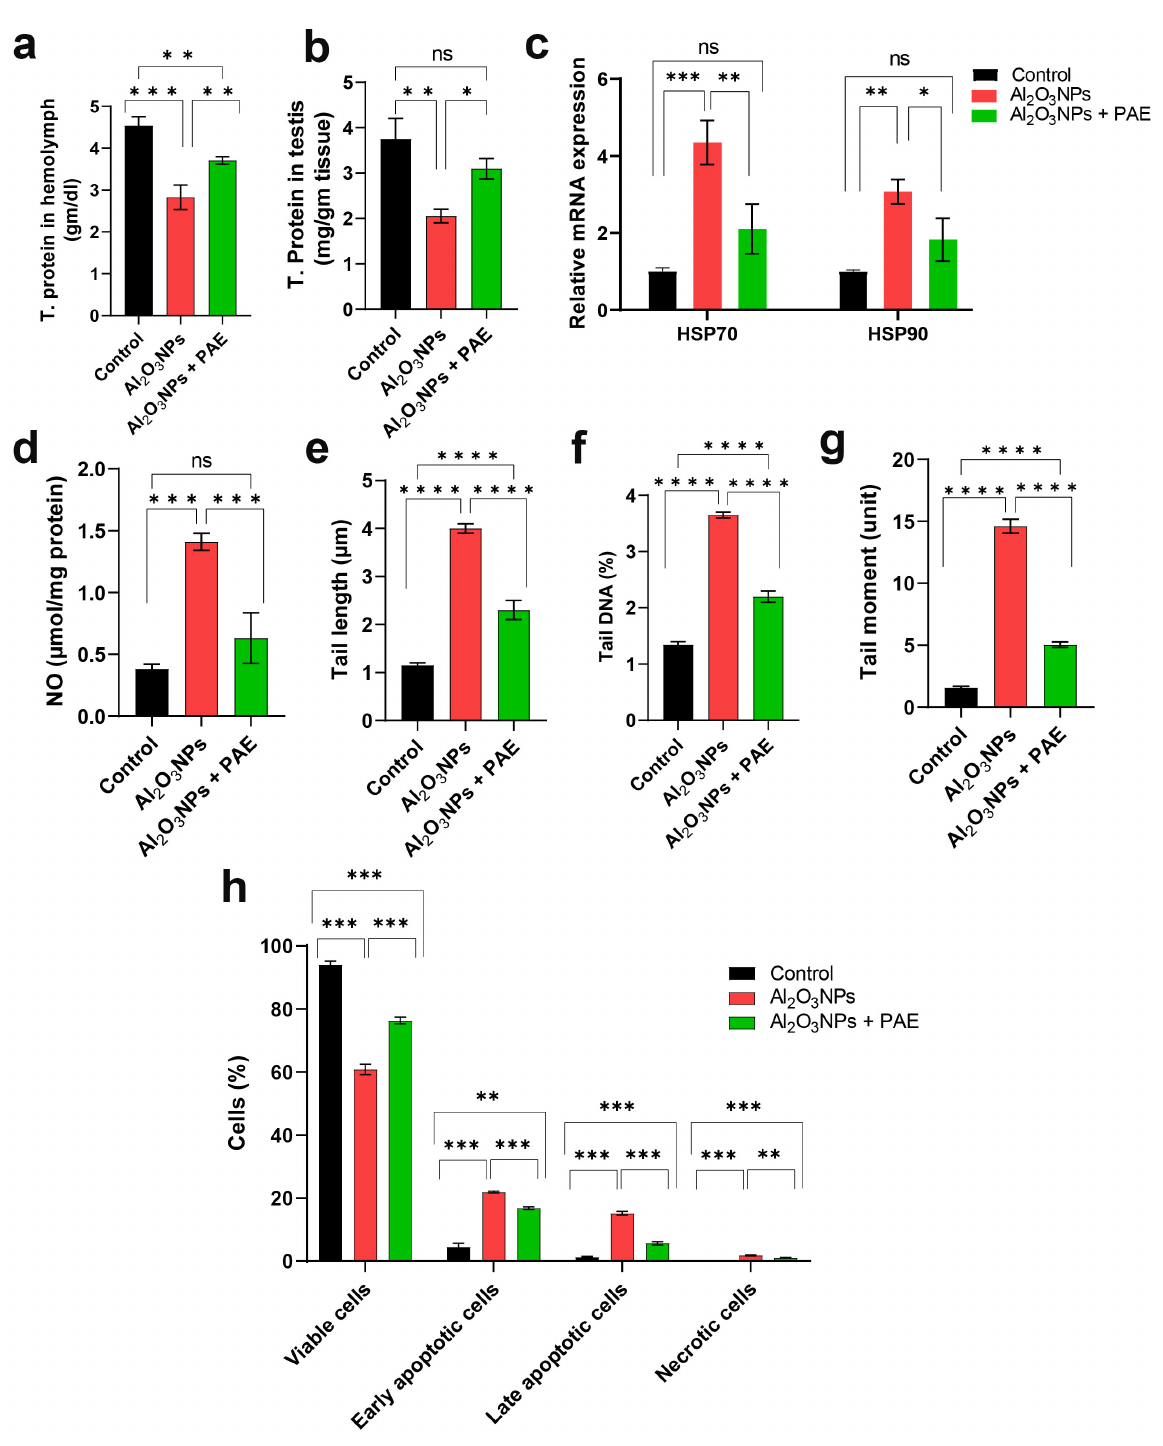
Figure 5. This is a figure. Schemes follow the same formatting. If there are multiple panels, they Figure 5. Total protein concentrations in ( a ) hemolymph and ( b ) testis, ( c ) relative expressions of HSP70 and HSP90 mRNA, and ( d ) nitric oxide were evaluated to determine the harmful effects should be listed as: ( a ) Description of what is contained in the first panel. ( b ) Description of what is induced in the testis by Al 2 O 3 NPs injection in L. migratoria with or without PAE treatment. ( e ) Comet contained in the second panel. Figures should be placed in the main text near to the first time they assay of DNA in cells extracted from testes, ( f ) tail length, DNA percentage in the comet tail, ( g ) tail are cited. A caption on a single line should be centered. moment, and ( h ) Annexin-V/PI assay results were also assessed. All investigations were replicated at least three times and data are shown as mean ± SD. For the comet assay, 50 to 100 randomly selected cells per slide were used. Data were analyzed with one-way ANOVA, followed by Tukey’s test for multiple comparisons. Different letters indicate significant differences between groups (**** p < 0.0001, *** p < 0.001, ** p < 0.01, * p < 0.05, and (ns) indicates a non-significant